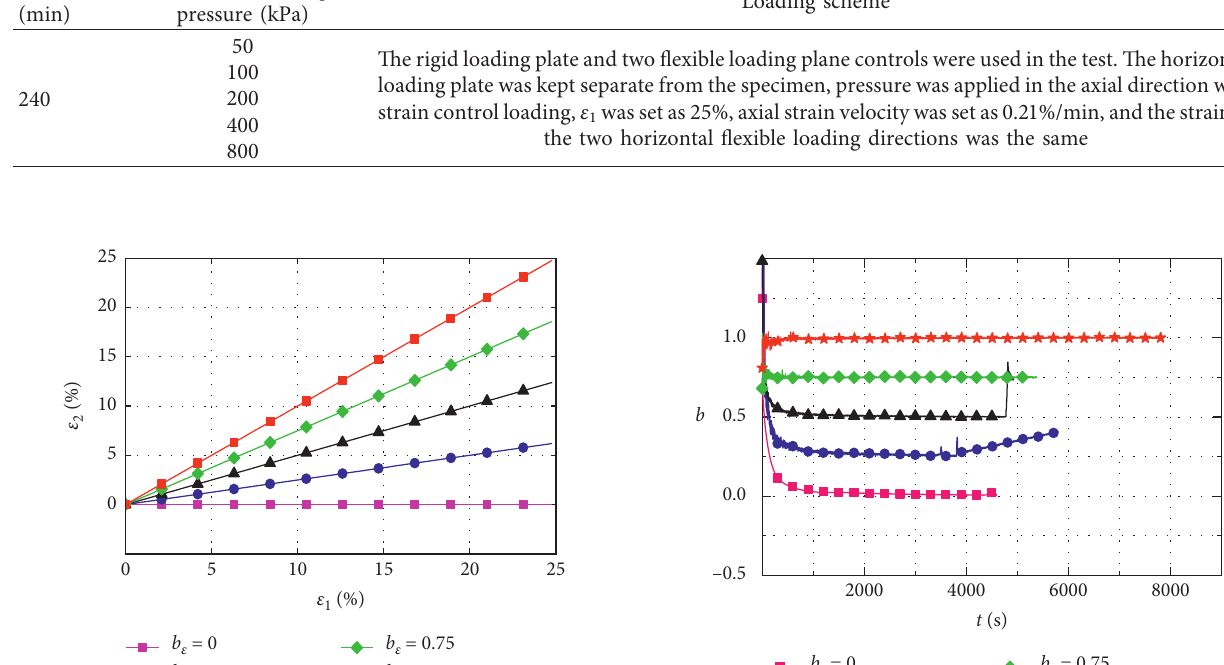
Table 3: Loading schemes with different σ